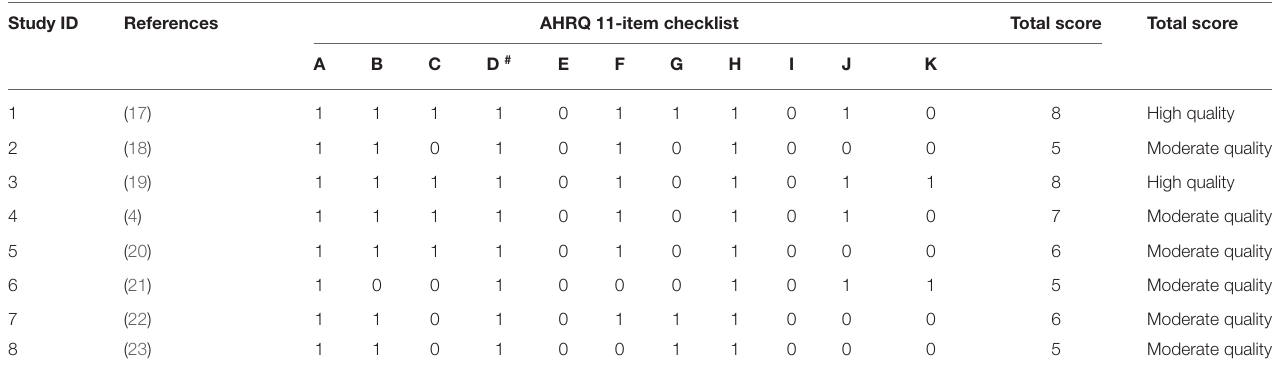
TABLE 2 | The quality evaluation of the methodology according to Agency for Healthcare Research and Quality (AHRQ, US 2004) assessment forms*. Study